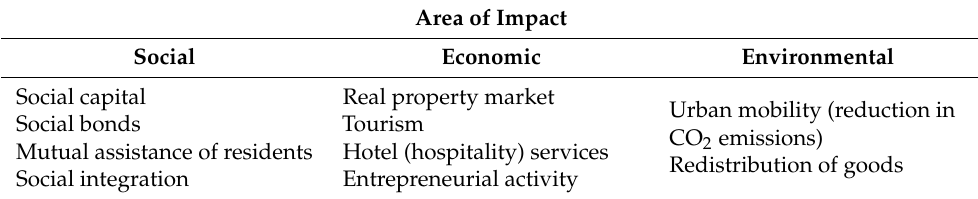
Table 2. Sharing economy and the area of its impact on a